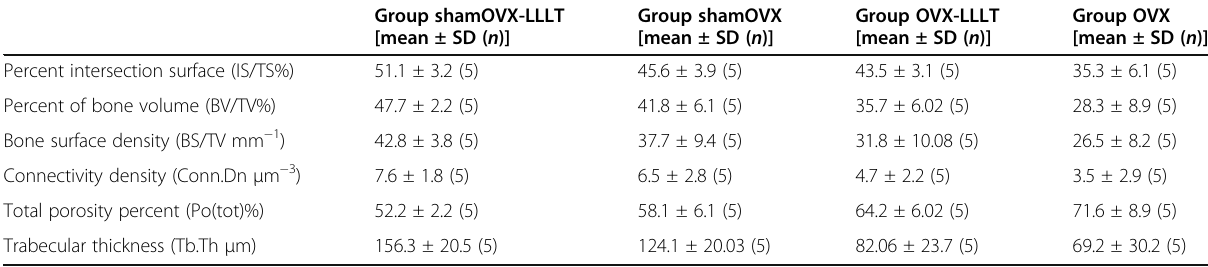
Trabecular thickness (Tb.Th μ m) Mean, standard deviation ( SD ) and number of subjects ( n